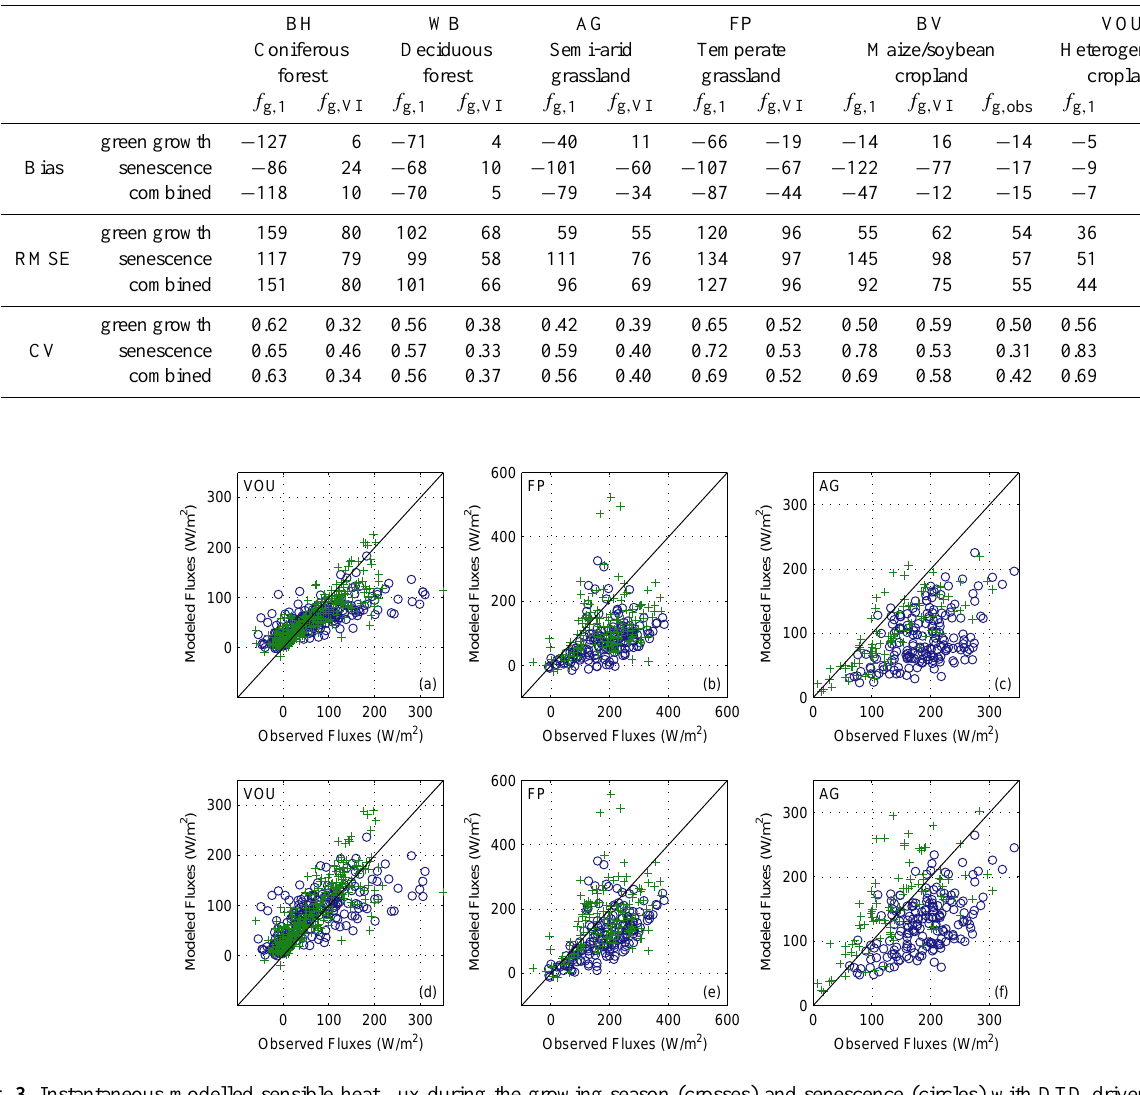
Fig. 3. Instantaneous modelled sensible heat flux during the growing season (crosses) and senescence (circles) with DTD driven by field measured LST with t 0 at one hour past sunrise at agricultural site (VOU, a and d ), temperate grassland (FP, b and e ) and semi-arid grassland (AG, c and f ). At the top with f g = 1 , at the bottom with f g adjusted based on MODIS VI. Senescence at VOU starts between day of year (DOY) 175 and 215, at FP between DOY 176 and 241 and at AG between DOY 239 and 261.